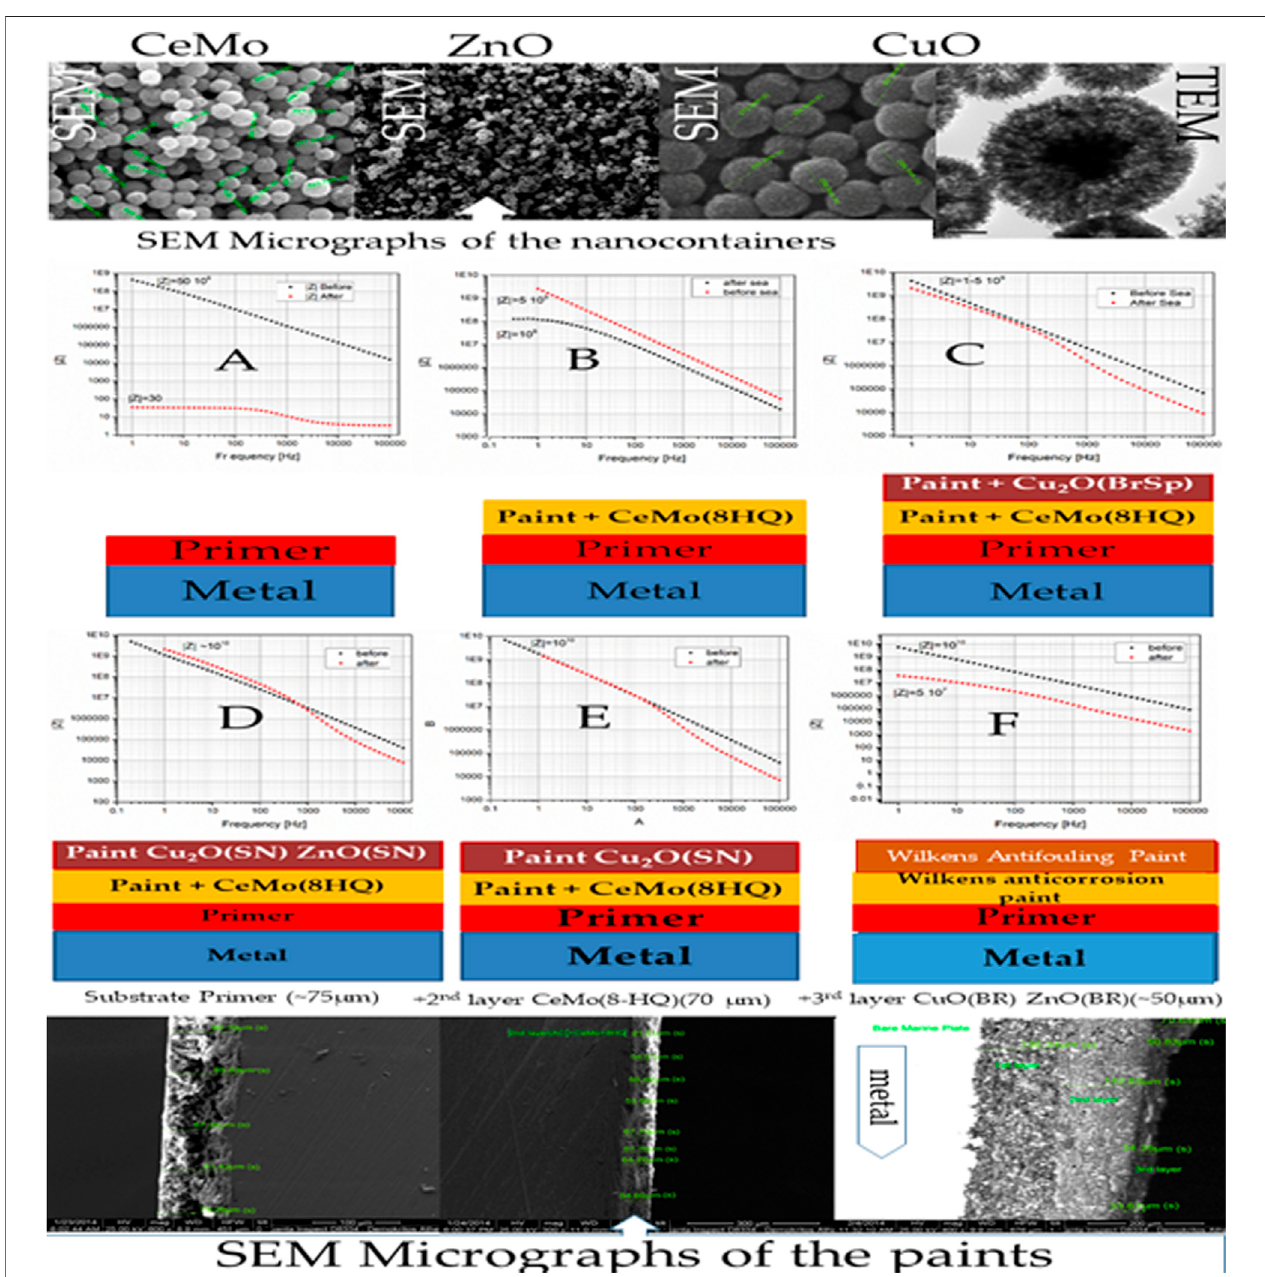
FIGURE2|(A) FRAoftheprimer, (B) FRAoftheprimerandanticorrosionpaintwith5 wt%CeMo(8-HQ), (C) FRAoftheprimer,theanticorrosionlayerwith5 wt% CeMo (8-HQ), and the antifouling topcoat with 5 wt% CuO (BrSp), (D) FRA of the primer, anticorrosion paint with 5 wt% CeMo (8-HQ), and the antifouling topcoat with 5 wt% CuO (SN) – ZnO (SN), (E) FRA of the primer, anticorrosion paint with 5 wt% CeMo (8-HQ), and the antifouling topcoat with 5 wt% CuO (SN) – ZnO (SN), (F) FRA of the primer, Wilkens anticorrosion, and antifouling paint. The symbol “ after ” in the graphs means 3-month exposure to seawater. Top fi gure: SEM of the CuO, ZnO, and CeMo nanocontainers as produced in the literature (Kordas, 2020a). The top right fi gure shows the TEM micrograph of CuO nanocontainers. The bottom fi gures present the SEM micrographs of the paints.